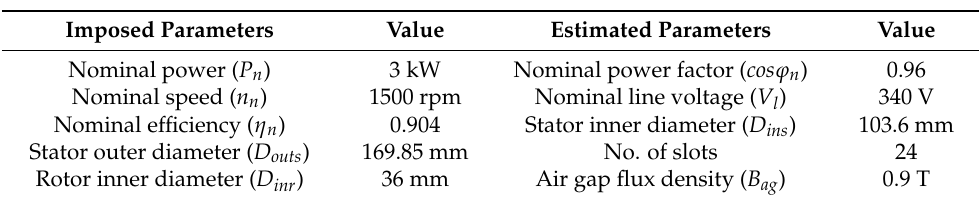
Table 1. Design parameters. Imposed Parameters